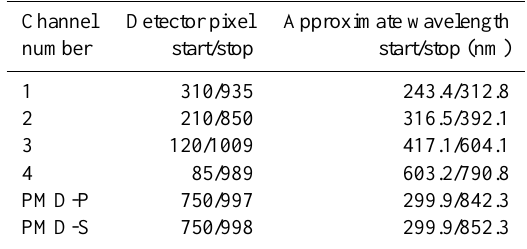
Table 7. Validity region of the etalon